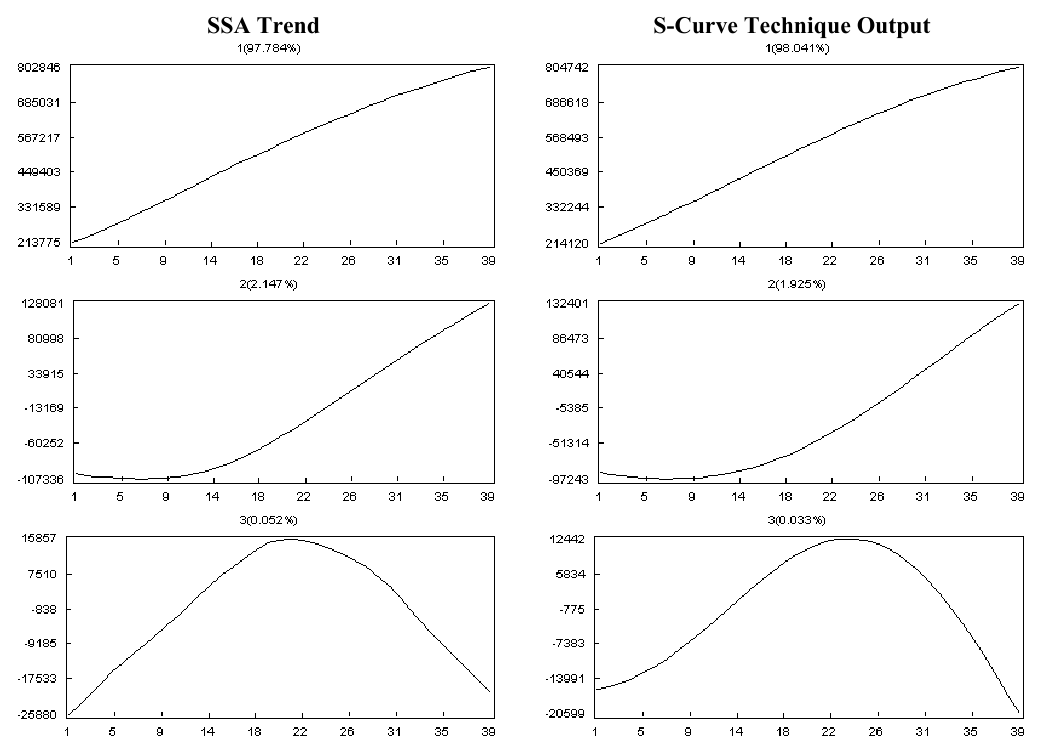
Figure 13. The residuals from the eigentriples 10 to 38.